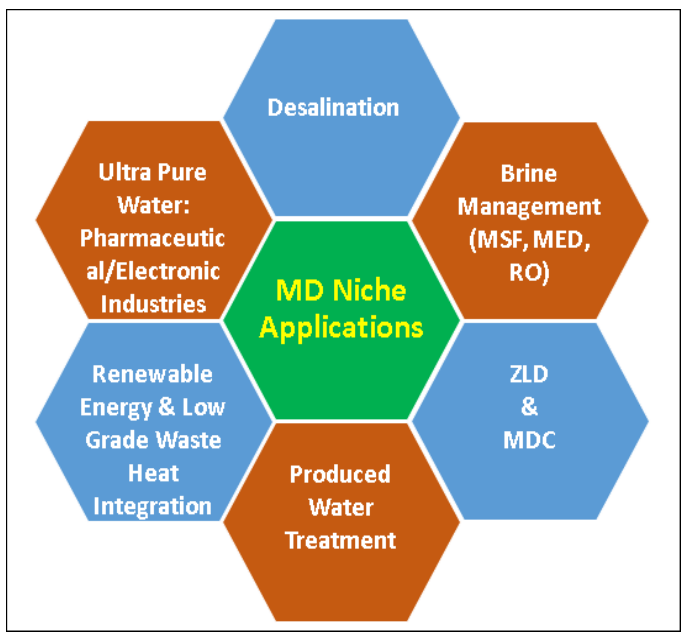
Figure 10. Niche applications of MD process.